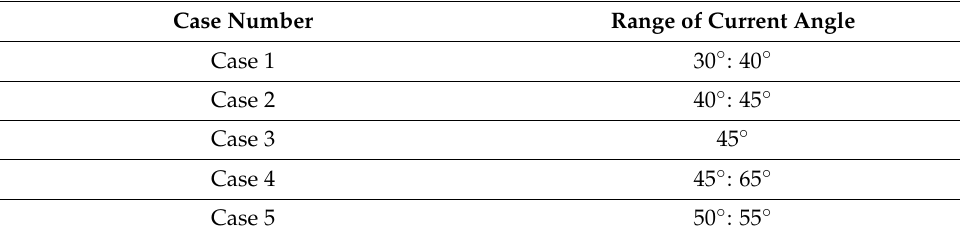
Table 3. Range of current angle for different